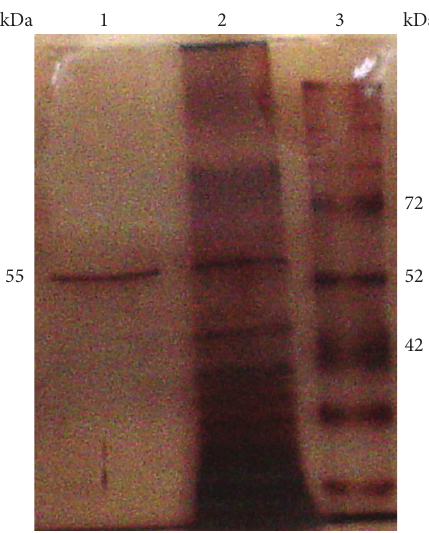
F 3: SDS Polyacrylamide gel electrophoresis (PAGE) showing